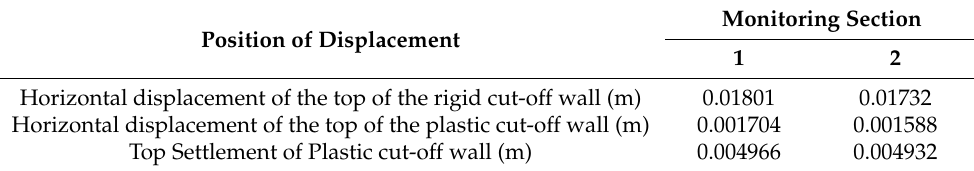
Table 2. Comparison of displacement and settlement of cut-off wall at different monitoring sections.